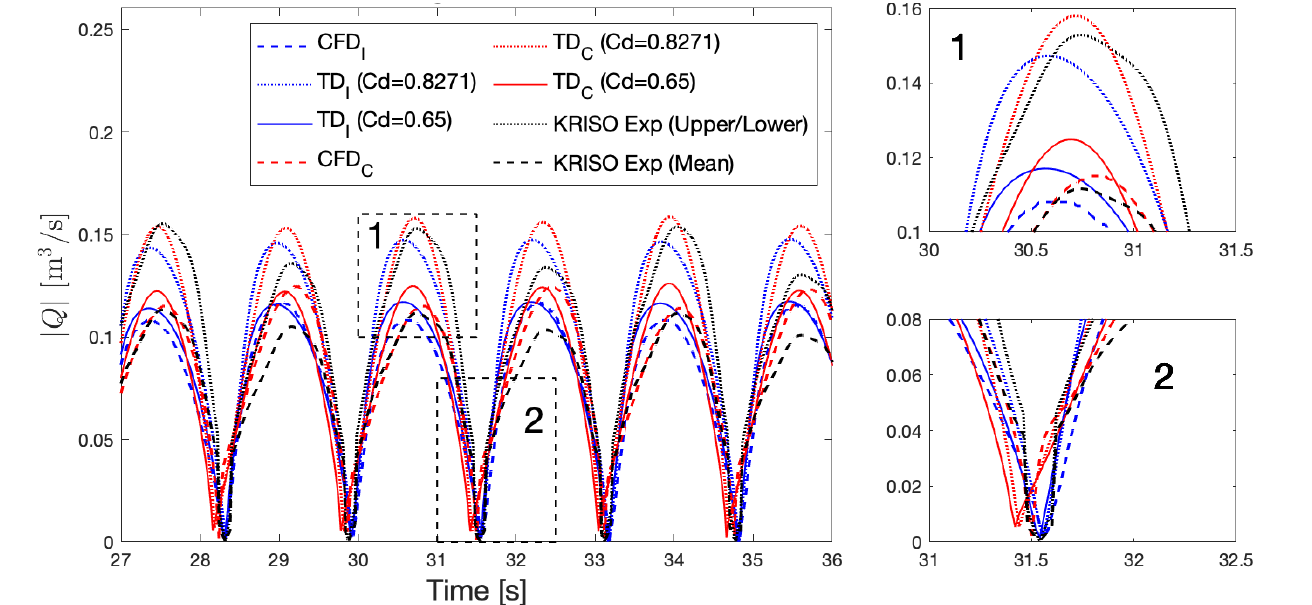
Figure 23. Comparison of the measured, Computational Fluid Dynamics (CFD), and potential flow pressure difference with a zoom at the peak and near the zero crossing for Test 106.